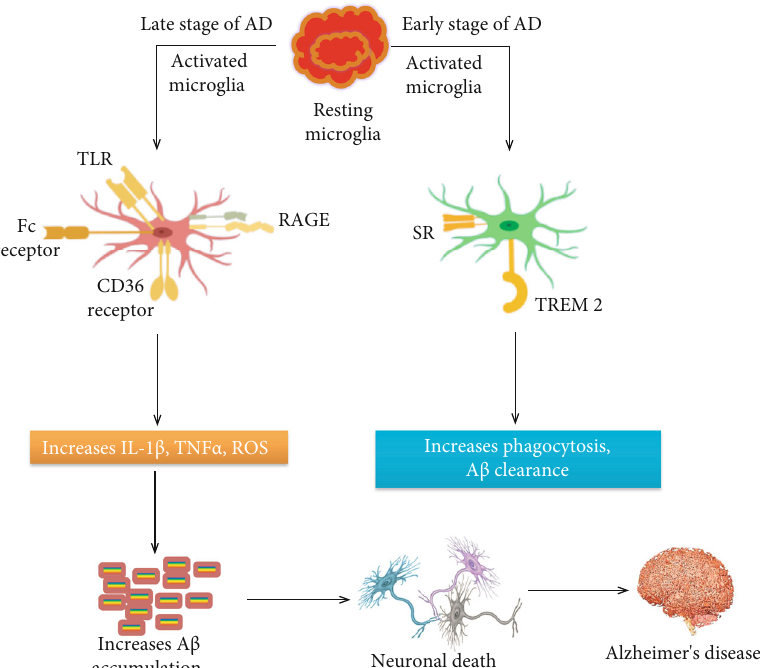
Figure 3: Possible mechanisms of action of activated microglia in di ff erent early and later stages of Alzheimer ’ s disease. In the early stages of AD, activated microglia may increase A β clearance through TREM2 and scavenger receptors. On the other hand, in the late stage of the disease, continuous microglial activation induced by A β through various receptors triggers a vicious cycle of microglial activation, neuroin fl ammation, and A β buildup that leads to AD. AD: Alzheimer ’ s disease; TLR: Toll-like receptor; RAGE: receptor for advanced glycation end products; IL-1 β : interleukin-1 β ; TNF- α : tumor necrosis factor- α ; ROS: reactive oxygen species; SR: scavenger receptor; TREM2: triggering receptor expressed on myeloid cell